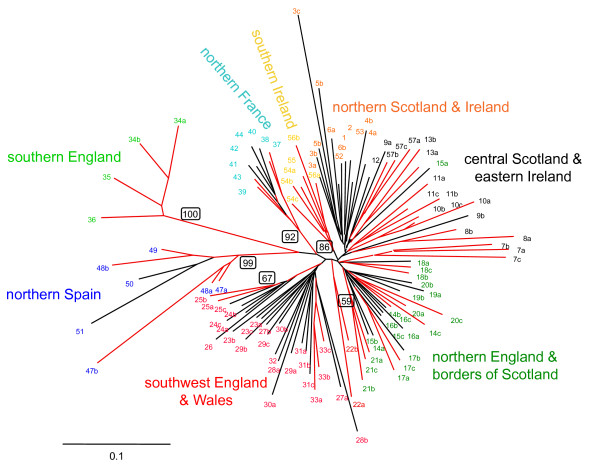
Neighbour-joining dendrogram of relationships defined between samples of Atlantic salmon analysed in this study. The DA distance measure of Nei et al. [49] was used and nodes highlighted in red were supported by bootstrap support of greater than 50% in 1000 pseudoreplicates; bootstrap values for key clades are given in a box on the relevant node. Colours and labels denote reporting region as follows: northern England & borders of Scotland (dark green), southwest England & Wales (red), northern Spain (blue), southern England (light green), northern France (light blue), southern Ireland (yellow), northern Scotland and Ireland (orange), central Scotland and eastern Ireland (black). Sample abbreviations follow those given in Additional File 1.